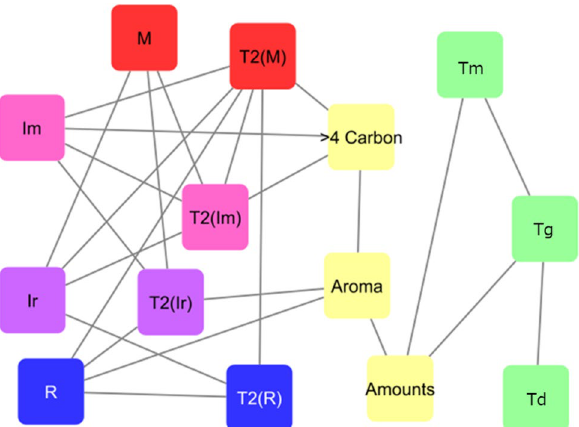
Figure 5. Selected MBA network for T 2 relaxation time data. From the results of the market basket analysis, only the relationships between the simulated domain structure information and T 2 relaxation time data, experimental melting temperature (T m ), thermal decomposition temperature (T d ), glass transition temperature (T g ), and data on primary structure were extracted. M: Mobile domain, Im: MAPE Filter-derived Intermediate domain (Intermediate (Mobile)), Ir: DQ Filter-derived Intermediate domain (Intermediate (Rigid)), R: Rigid domain, T2(M): T 2 relaxation time information for mobile domain, T2(Im): T 2 relaxation time information for Intermediate (Mobile) domain, T2(R): T 2 relaxation time information for rigid domain, T2(Ir): T 2